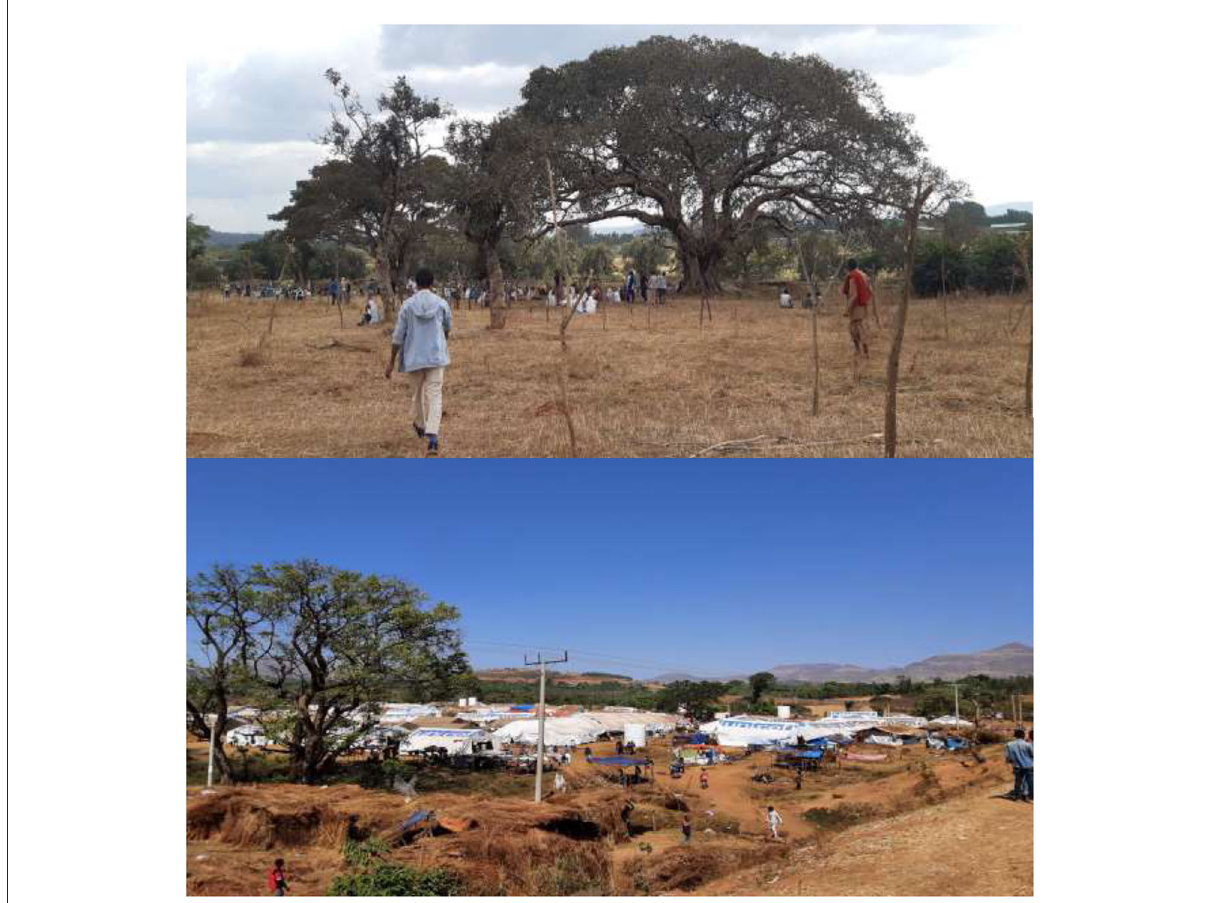
FIGURE2 Ranch self and planned settlement site, Changi, Ethiopia, November 2020 up to June